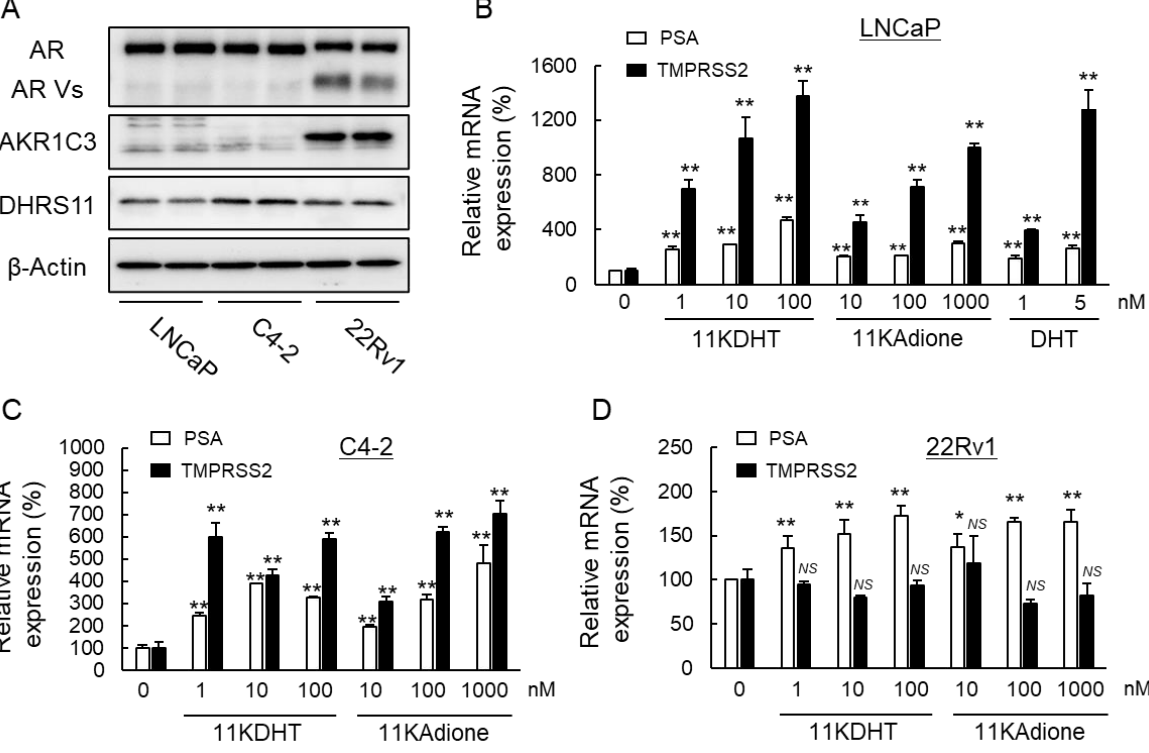
Figure 2. Differences in the expression of 17βHSDs and androgen sensitivity among three PC cell lines (LNCaP, C4-2 and 22Rv1). ( A ) Expression of AR, AKR1C3 and DHRS11 were detected by im- munoblotting. ( B – D ) Effects of 11-ketoandrogens on androgen signaling in LNCaP ( B ), C4-2 ( C ) and 22Rv1 ( D ) cells. The cells were treated for 24 h with the indicated concentrations of 11KDHT, 11KA- dione or DHT. The mRNA expression levels of PSA and TMPRSS2 in the cells were analyzed by RT-qPCR analysis. ** p < 0.01, * p < 0.05, NS p > 0.05 compared with the control cells treated with DMSO alone.